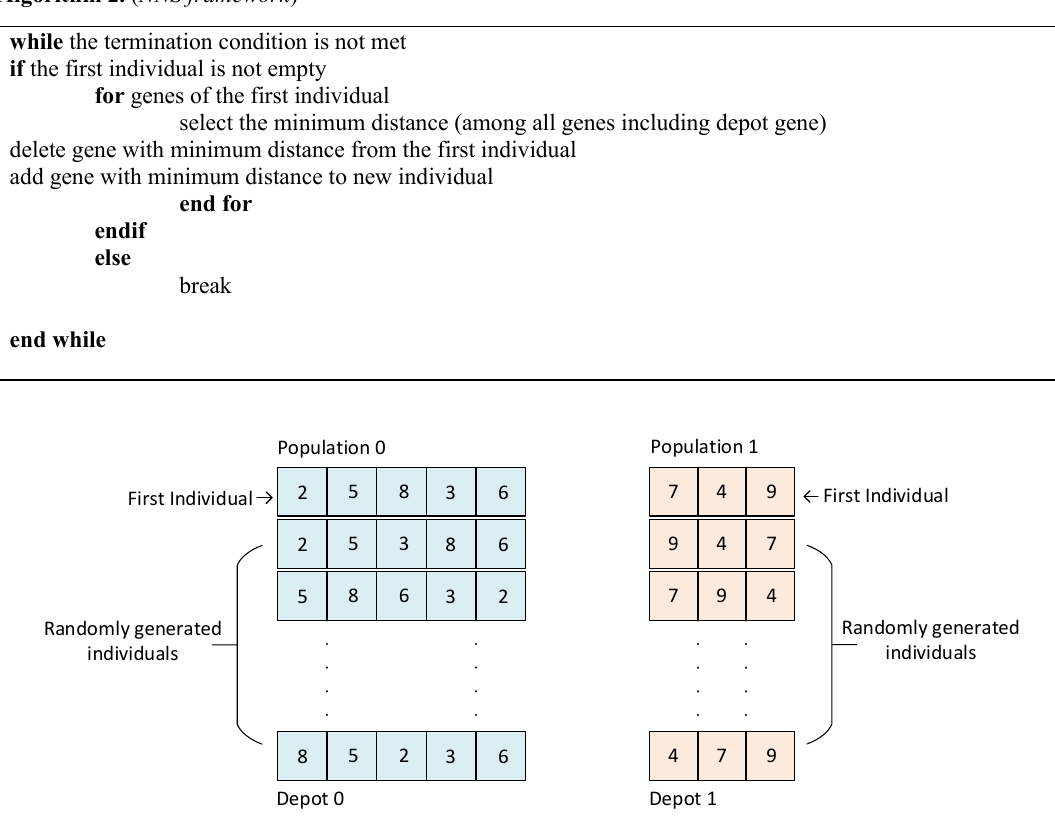
Algorithm 2. ( NNS framework )